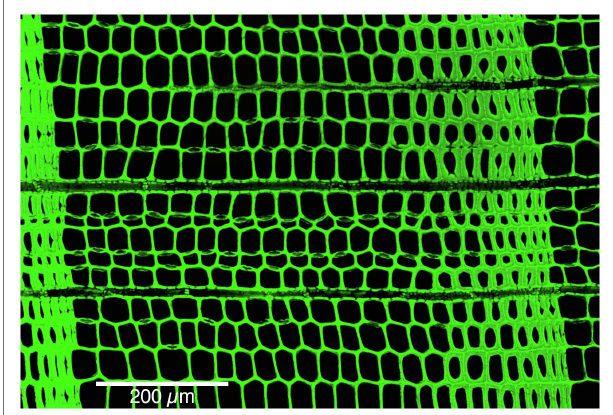
FIGURE 2 | Microscopic composite (merged) image of Pseudotsuga menziesii at 300x magnification with brightness